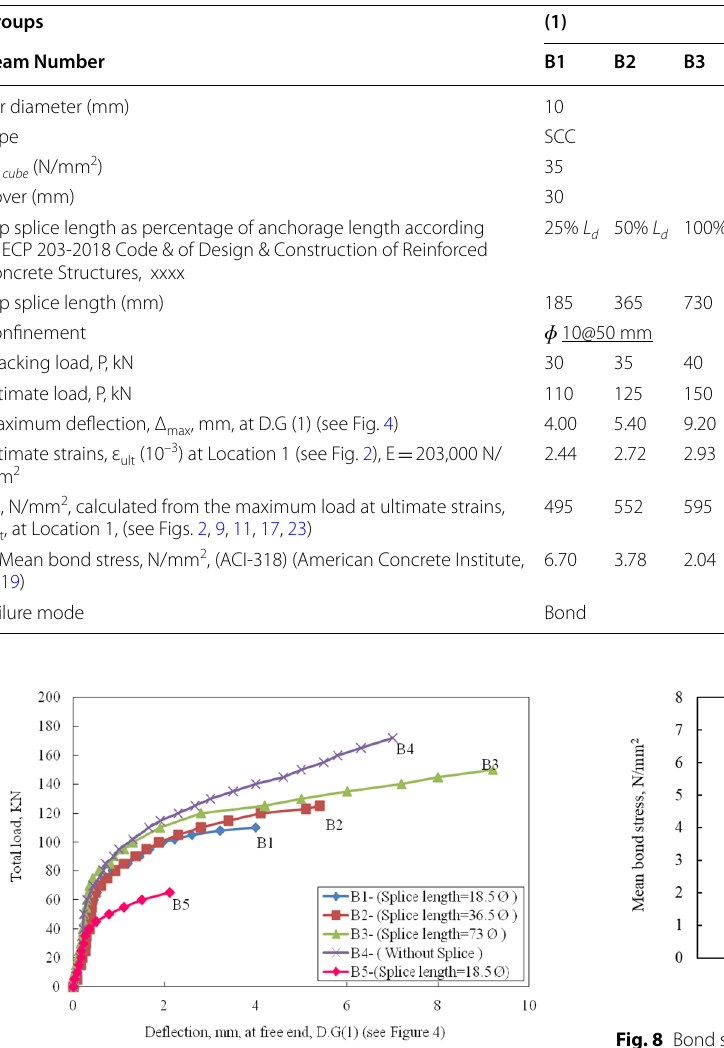
Fig. 6 Load–deflection curves for Group 1 (B1, B2, B3, B4, and B5)